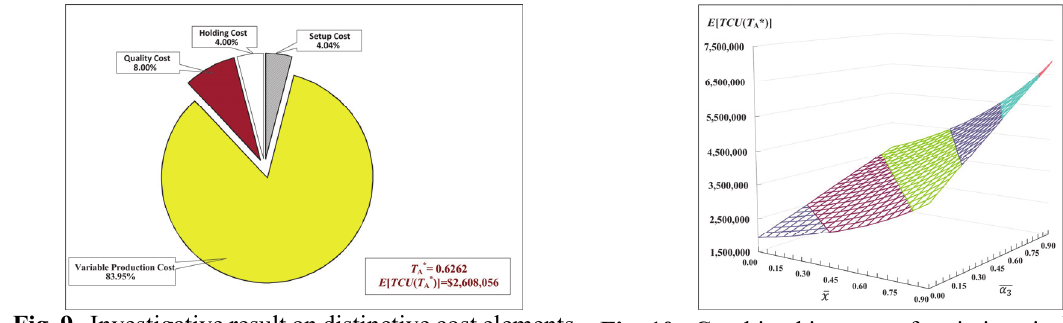
Fig. 10. Combined impacts of variations in x and  on E [ TCU ( T A 3